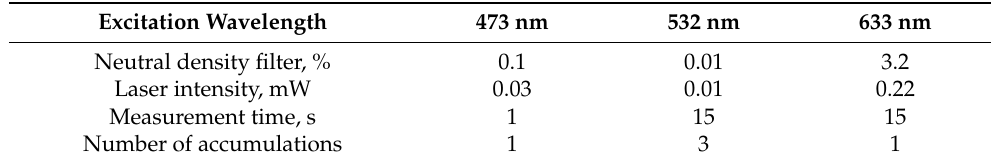
Table 2. Measurement